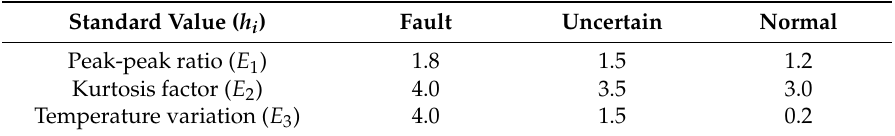
Table 1. The standard values of evidence